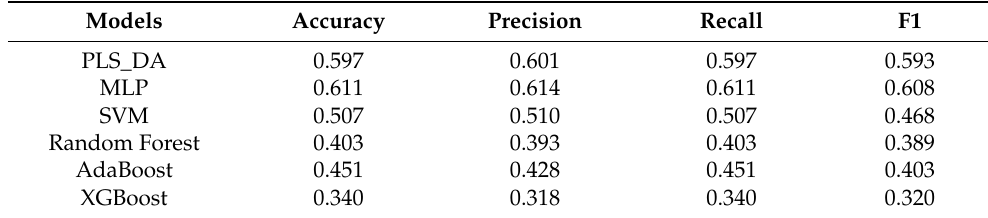
Table 3. The validation set results for spectral feature classification models.